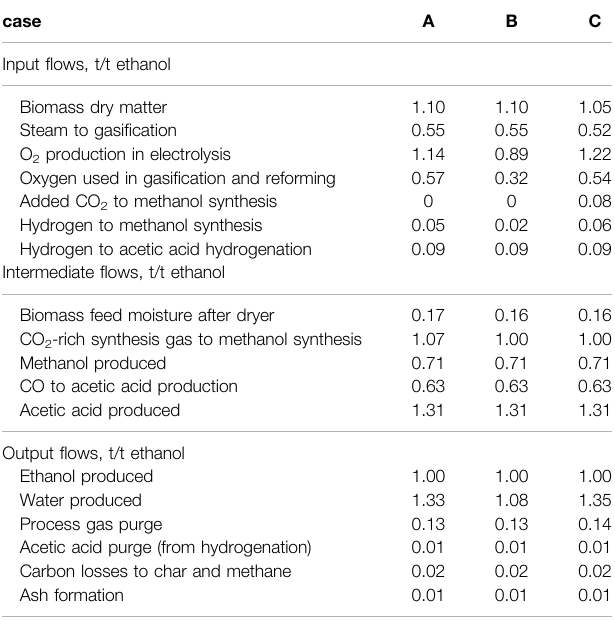
TABLE 4 | Mass balance of case A – C (t per t of ethanol